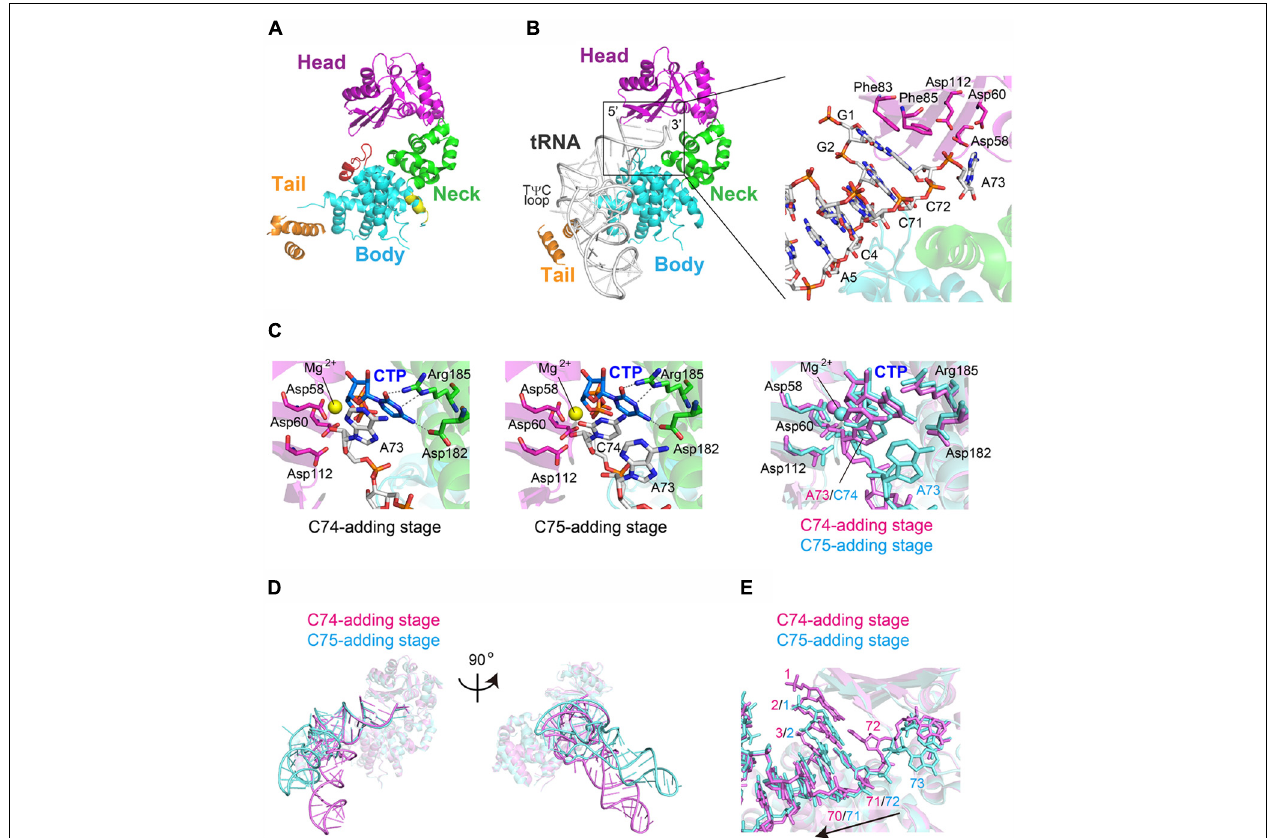
pocket of AaS at the C 74 -adding (left) and C 75 -adding (middle) stages. CTPs are depicted by stick models. The superimposition of the structures at C 74 -adding (magenta) and C 75 -adding (cyan) stages (right). (D) Comparison of the overall complex structures of AaS at the C 74 -adding (cyan) and C 75 -adding (pink) stages. (E) Detailed view of the superimposed structures of the tRNA acceptor helices at the C 74 -adding (cyan) and C 75 -adding (pink) stages in (D)